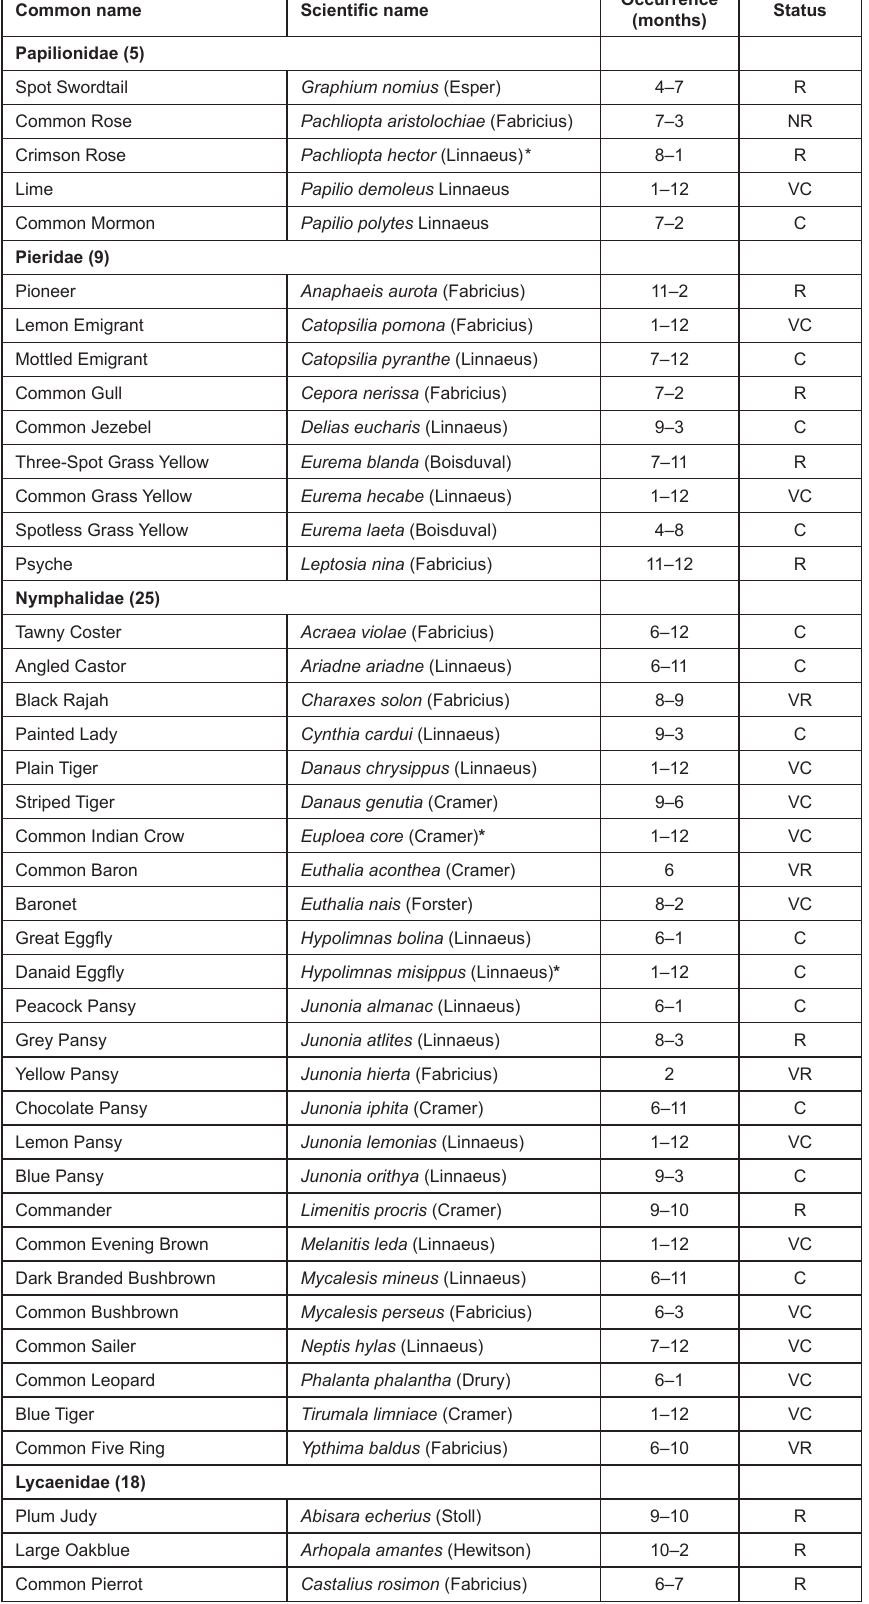
Table 1. List of butterflies recorded from TFRI Campus together with common name and